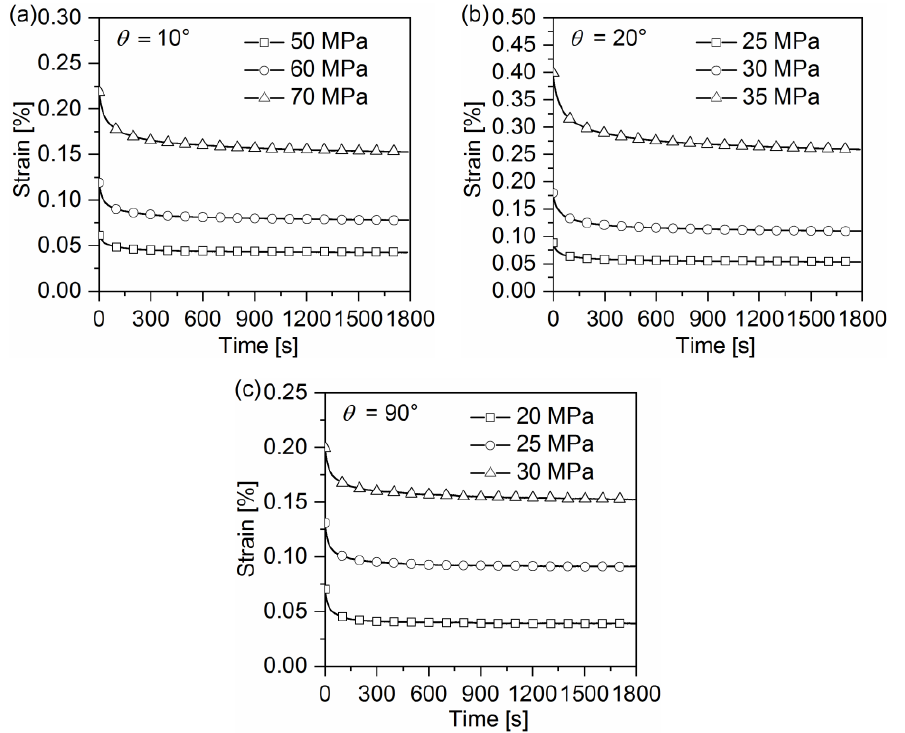
Figure 5. Strain-time curves of the quasi-UD E-glass/polypropylene composite for the strain recovery at zero stress point and with various peak stresses: ( a ) 10° off-axis sample, ( b ) 20° off-axis sample, and ( c ) 90° off-axis sample.